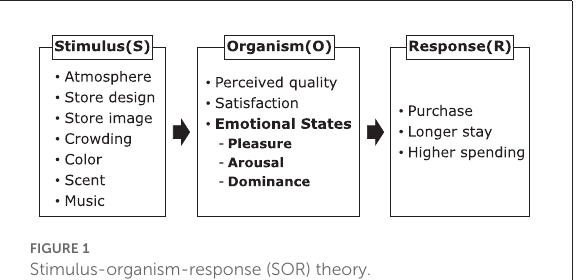
FIGURE1 Stimulus-organism-response (SOR)